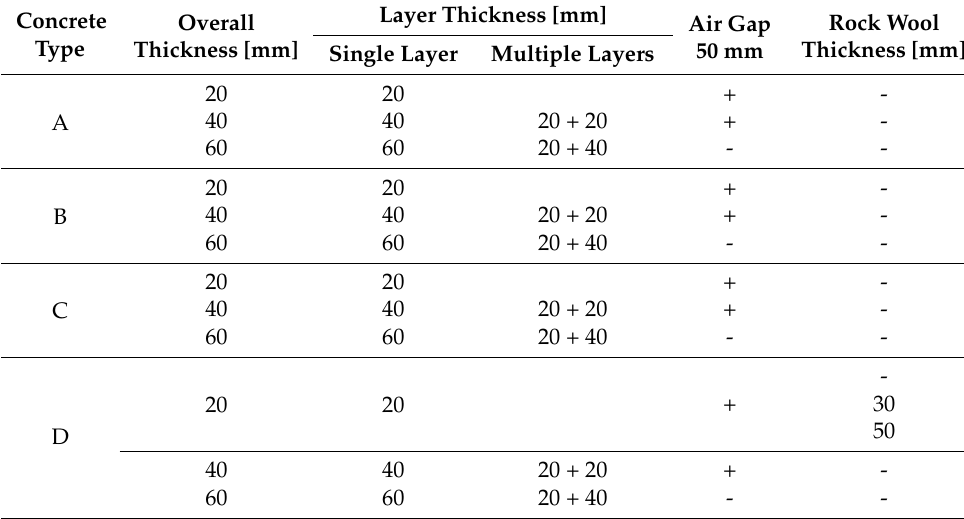
Table 2. Summary of the tested samples and configurations of the porous concrete. Single layers have been tested in configurations of multiple layers, with air gap and with rock wool in the airgap (+tested and − untested configurations of single layers).